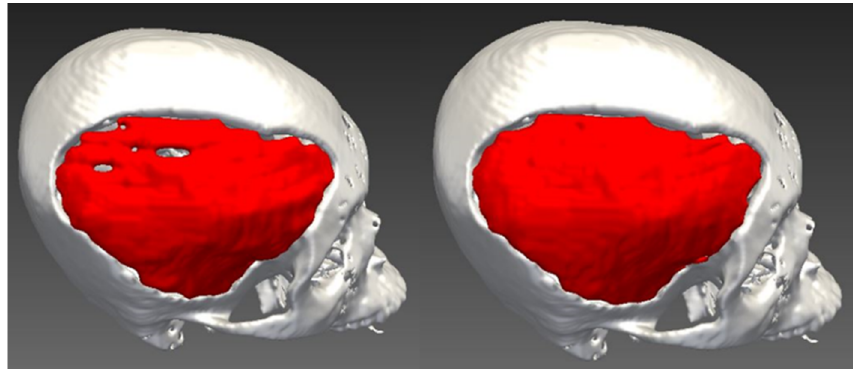
Figure 6. The final cranial implant before editing ( left ) and after editing ( right ).